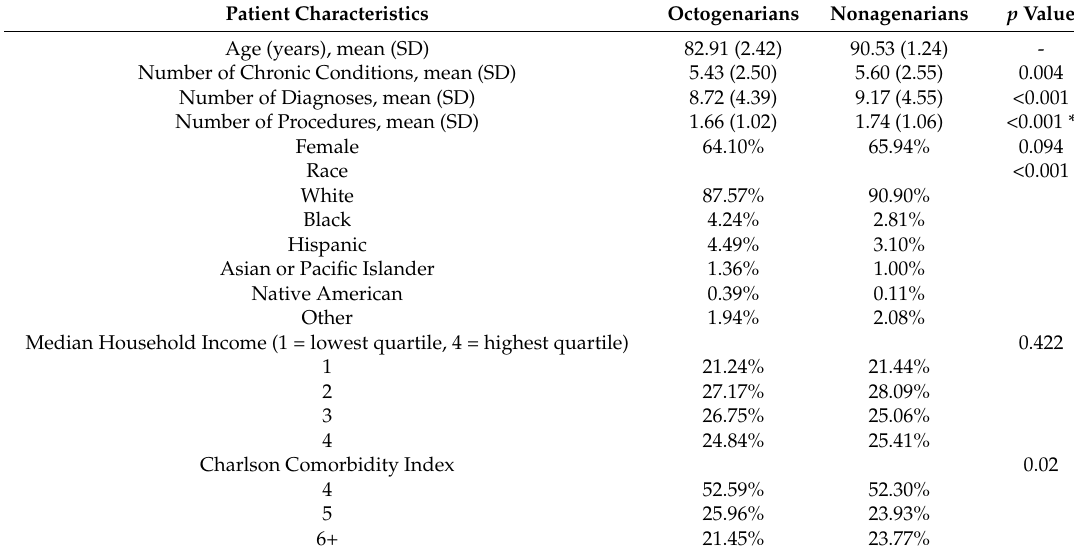
Table 1. Comparing characteristics of patients undergoing primary total knee arthroplasty between octogenarians and nonagenarians. Healthcare Cost and Utilization Project—Nationwide Inpatient Sample,